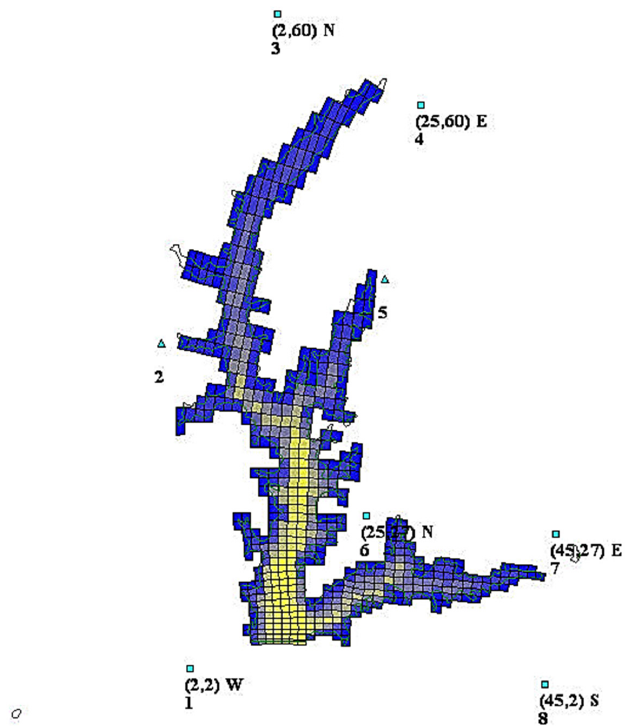
Figure 2. Grid showing the Converse Reservoir with eight control points and 575 cells used in Environmental Fluid Dynamics Code (EFDC) modeling. Cell colors correspond with bottom elevation in meters above mean sea level. Numbers represent the horizon.